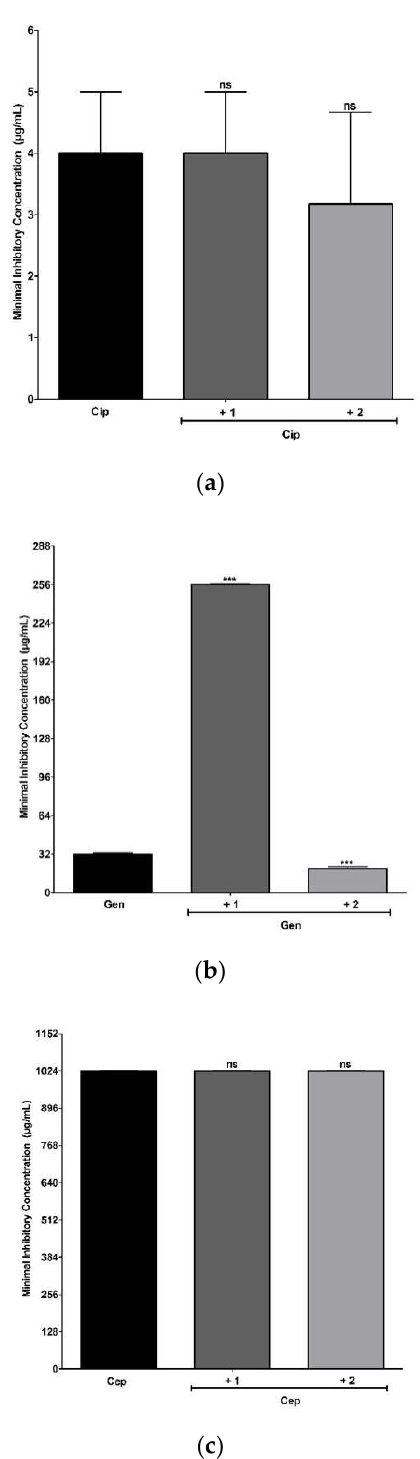
Figure 9. MICs of the Ciprofloxacin (Cip) (a), Gentamicin (Gen) (b), and Cephalexin (Cep) (c) in the absence or presence of the chalcones 1 and 2 at sub-inhibitory concentrations (MIC 1/8) against multidrug-resistant E. coli . Each result is the geometric mean of three simultaneous experiments. (***) Statistically significant values ( p < 0.0001).